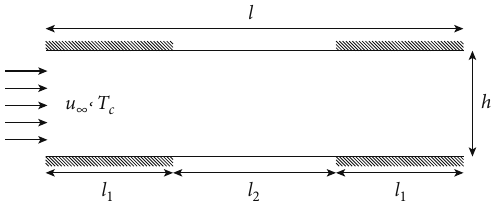
Figure 1: Physical schematic of the